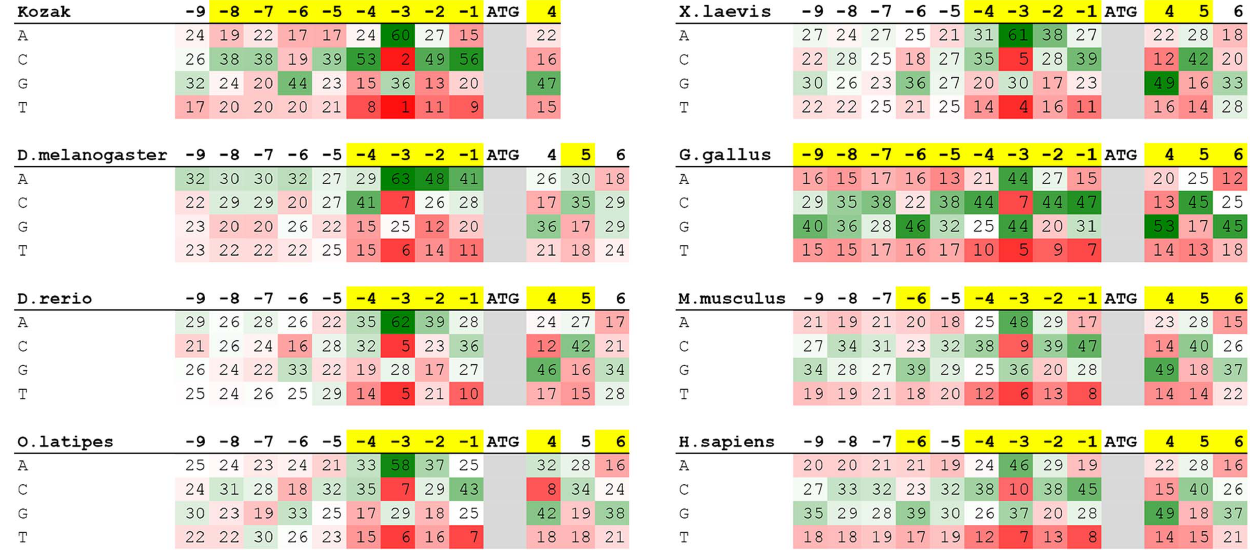
Figure 1. Quantitative sequence analysis reveals positive selection for nucleotides surrounding translational start sites. 2 9 to + 6 nucleotide frequencies (%) are presented for the consensus Kozak sequence and 7 model species. Yellow indicates positions with statistically significant selection (p , 0.03). Frequencies are color coded on a 3 color gradient from 0% (red) to 25% (white) to . 50% (green).